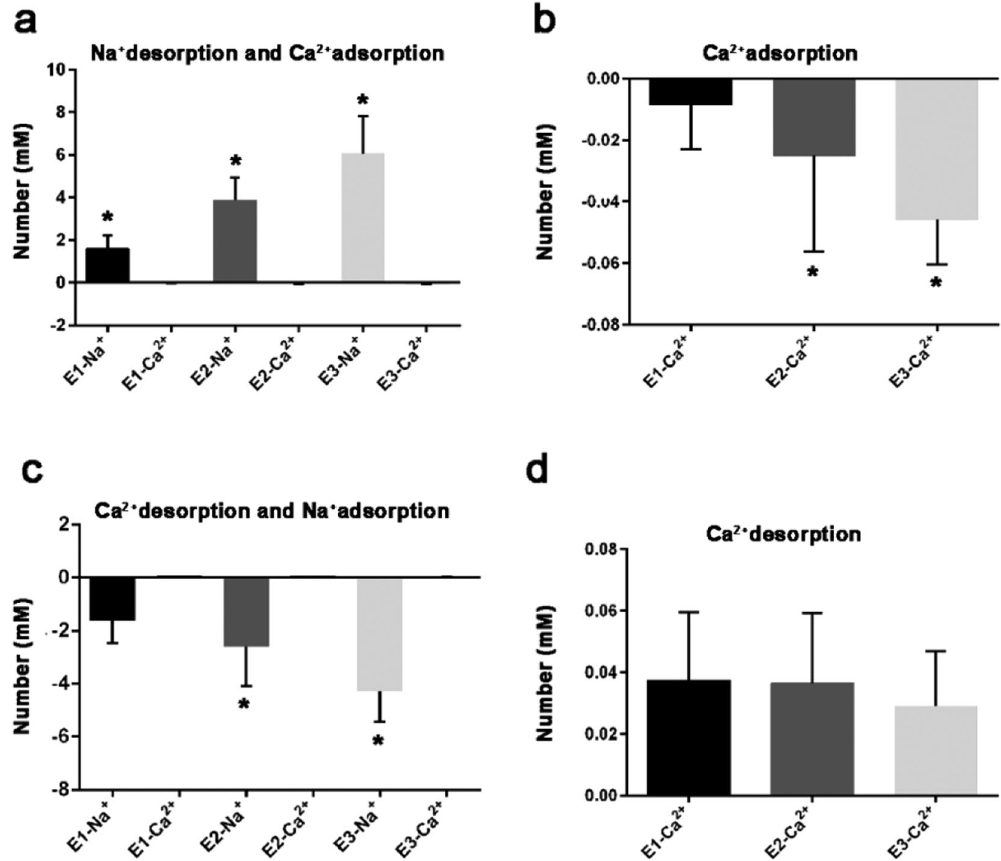
Figure 1. Impact of Na + concentration change in extracellular fluid on the adsorbed Ca 2+ and Na + of cardiomyocytes surface. In the Ca 2+ adsorption experiment, the number of Ca 2+ adsorbed was compared with the number of Na + desorbed ( a ). The number of Ca 2+ was adsorbed ( b ). In the Na + adsorption experiment, the number of Na + adsorbed was compared with the number of Ca 2+ desorbed ( c ). The number of Ca 2+ was desorption ( d ). (E-1, E-2 and E-3 were 105 mM NaCl group, 70 mM NaCl group and 35 mM NaCl group). * P < 0.05, comparison of rightward circulation among the three